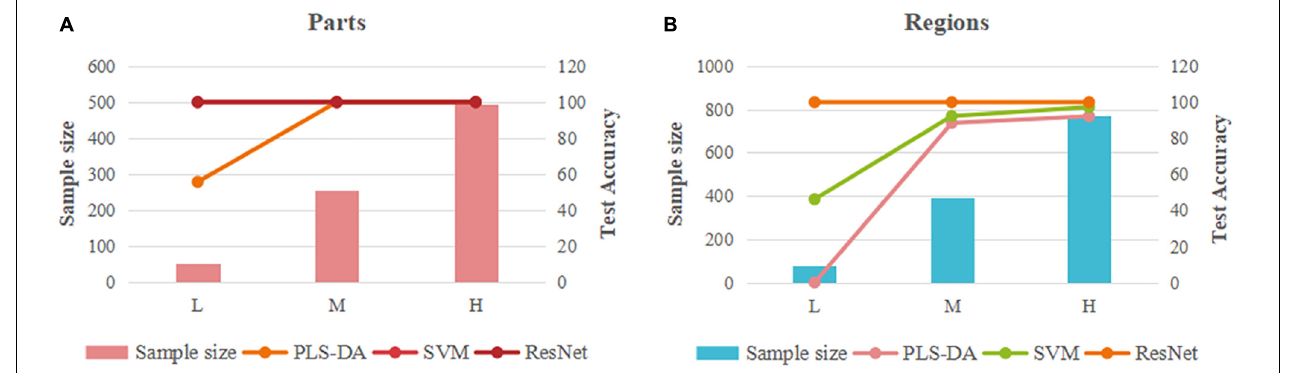
FIGURE 8 | Comparison of the overall identification performance of PLS-DA, SVM and ResNet models. (A) parts; (B)